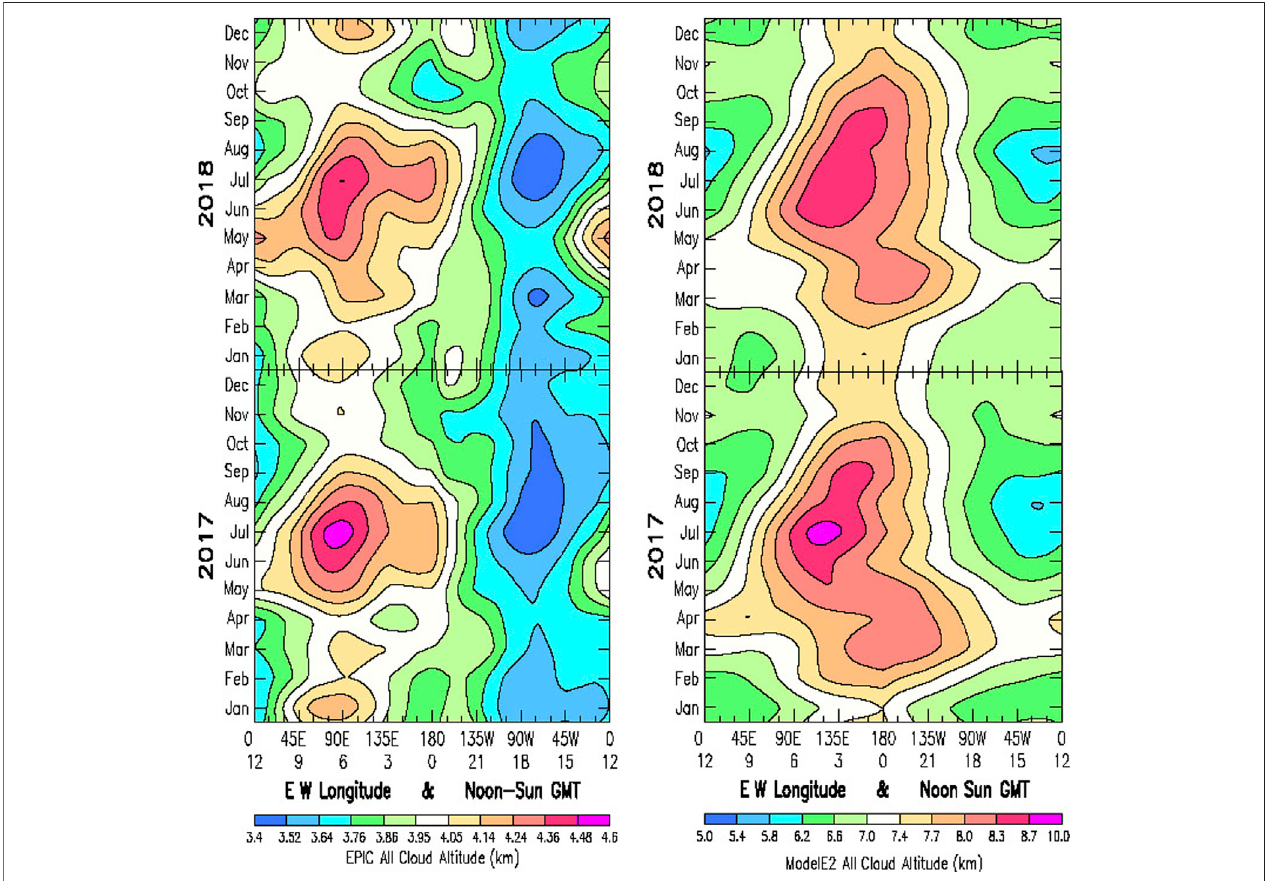
FIGURE 8 | Hovmöller plots of the EPIC (Left) all-cloud cloud-top altitude from EPIC Composite analysis results for 2017 and 2018, and ModelE2 (Right) from GISS ModelE2 climate simulations for the years 2017 and 2018, for the corresponding line plots of cloud-top altitude in Figure 7 .